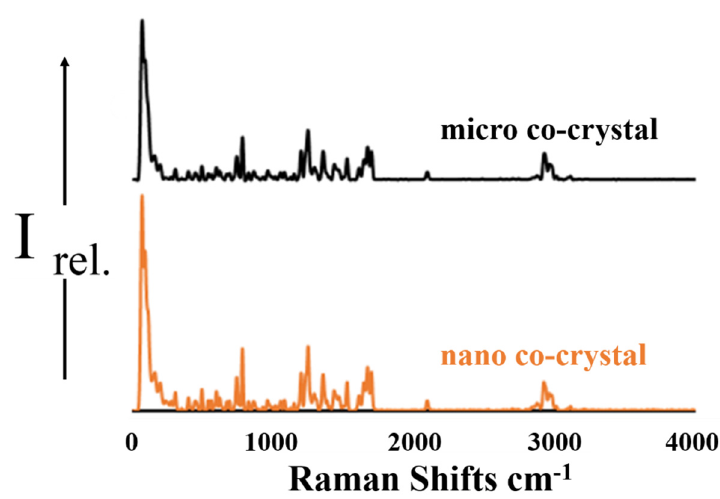
Figure 2. A stacked plot of the Raman spectra for the micro (black) and nano co-crystals (orange).